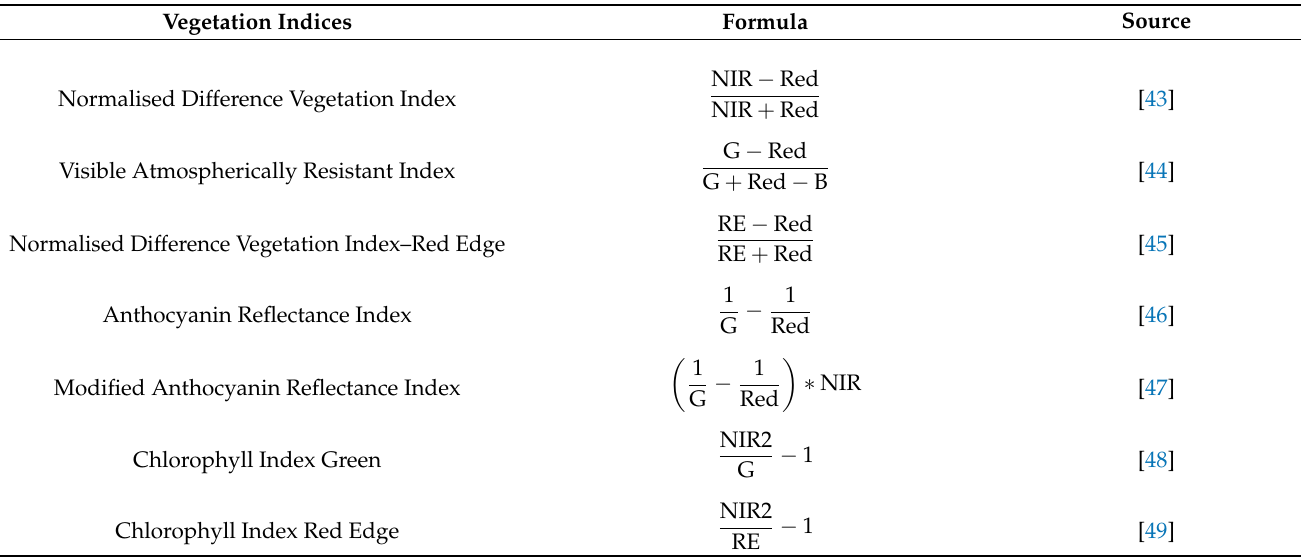
Table 3. Vegetation indices ‐ based predictor used for tree species classification.